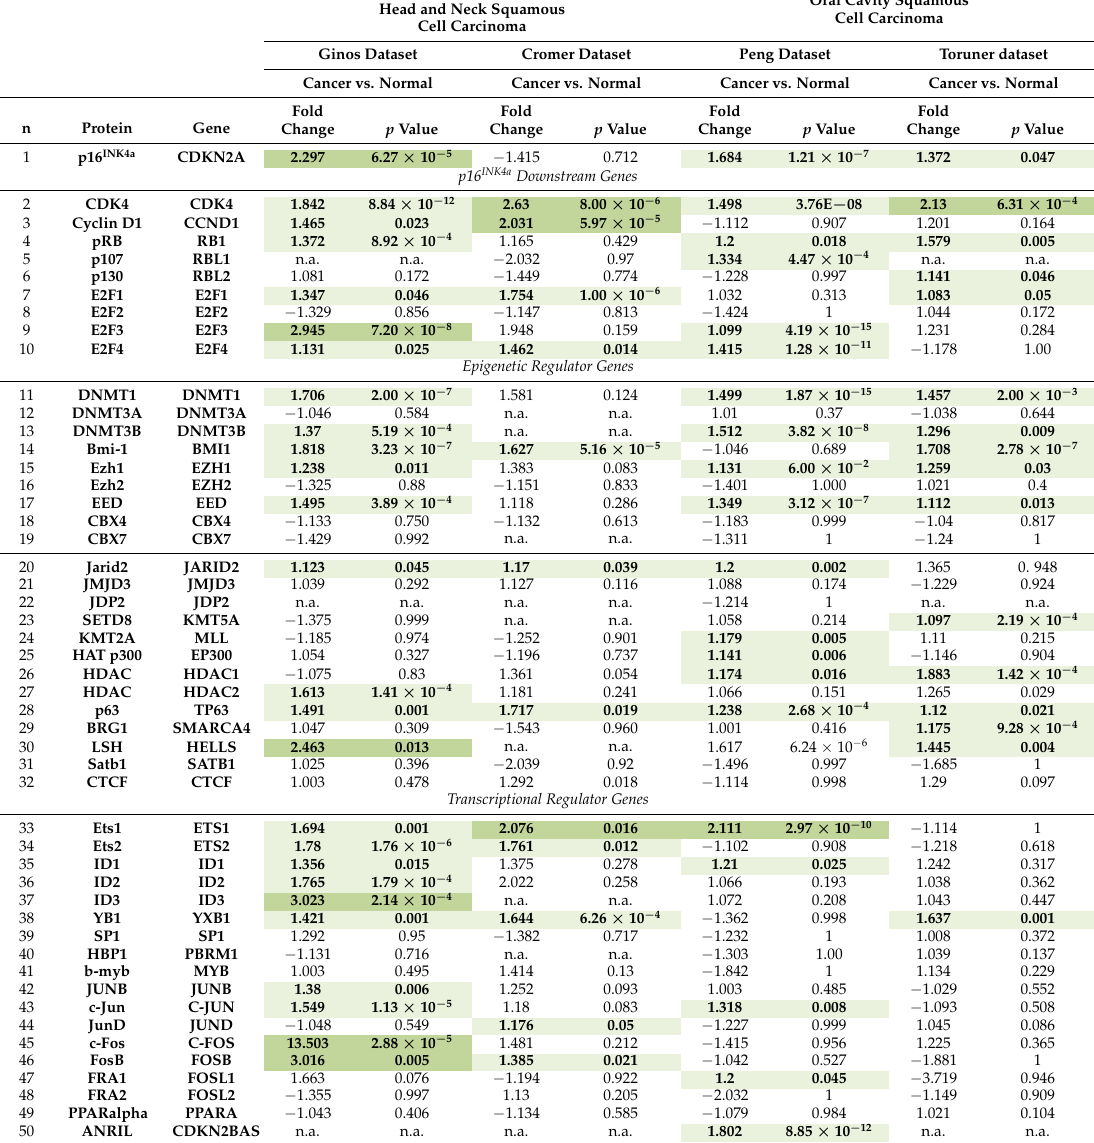
Table 3. Expression fold change of the genes investigated in the present study, from Head and Neck Squamous Cell Carcinoma and Oral Cavity Squamous Cell Carcinoma databases. Oral Cavity Squamous Head and Neck Squamous Cell Carcinoma Cell Carcinoma Ginos Dataset Cromer Dataset Peng Dataset Toruner dataset Cancer vs. Normal Cancer vs. Normal Cancer vs. Normal Cancer vs.